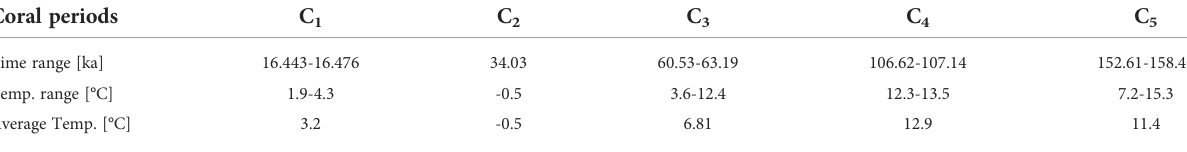
TABLE 2 Coral periods C 1 -C 5 , their time range, temperature range and average